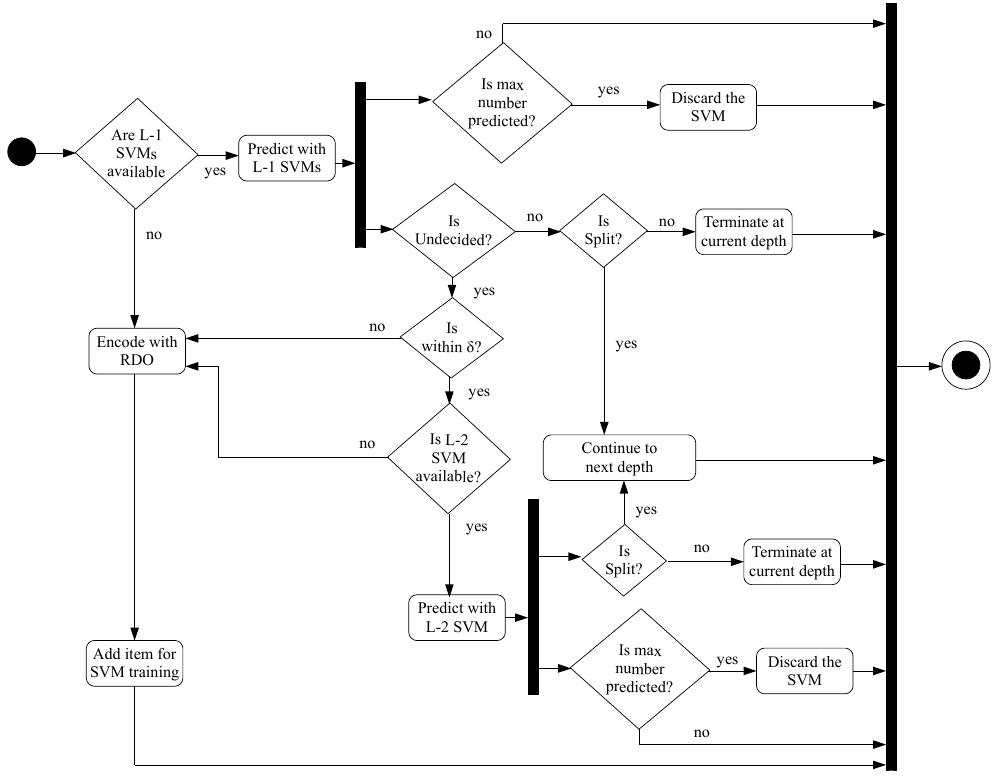
Figure 5. An activity diagram illustrating the proposed overall encoding algorithm (RDO: Rate-Distortion